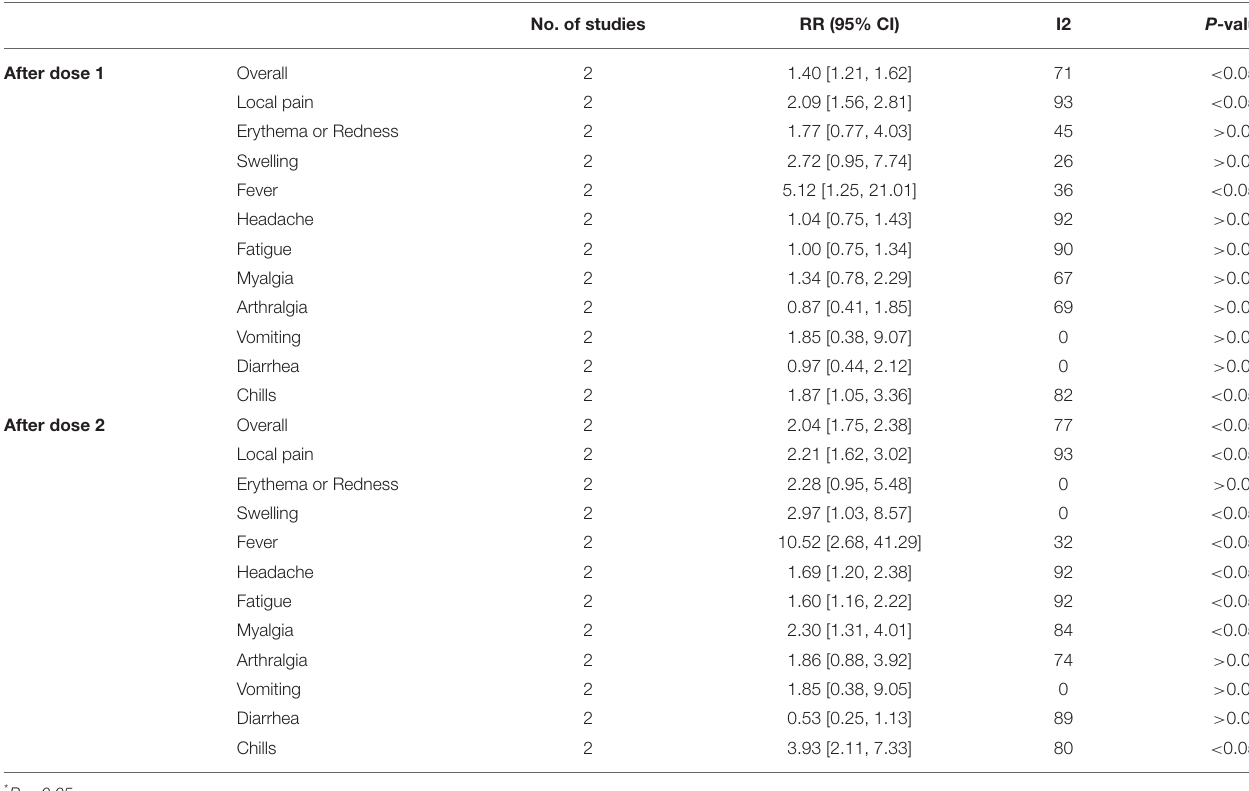
TABLE 6 | Specific adverse reactions in mRNA vaccine recipients aged ≥ 12 years vs. < 12 years.